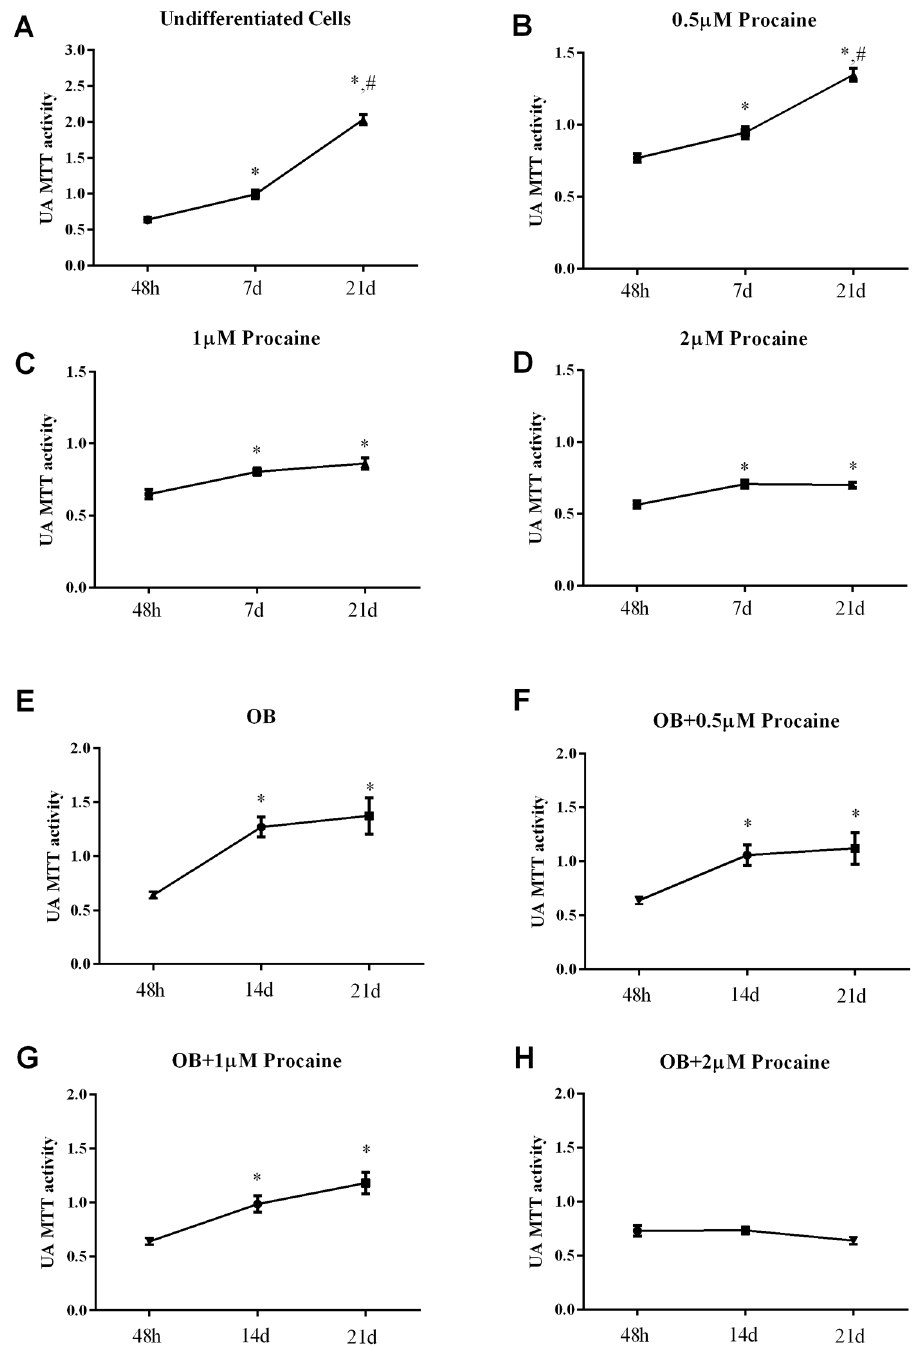
Fig 6. Non cytotoxic effect of Procaine. The effect of several doses of procaine (0.5, 1 and 2 μ M) on cell proliferation and viability was studied onundifferentiated mesenchymal stem cells (UC) (A), MSC plus